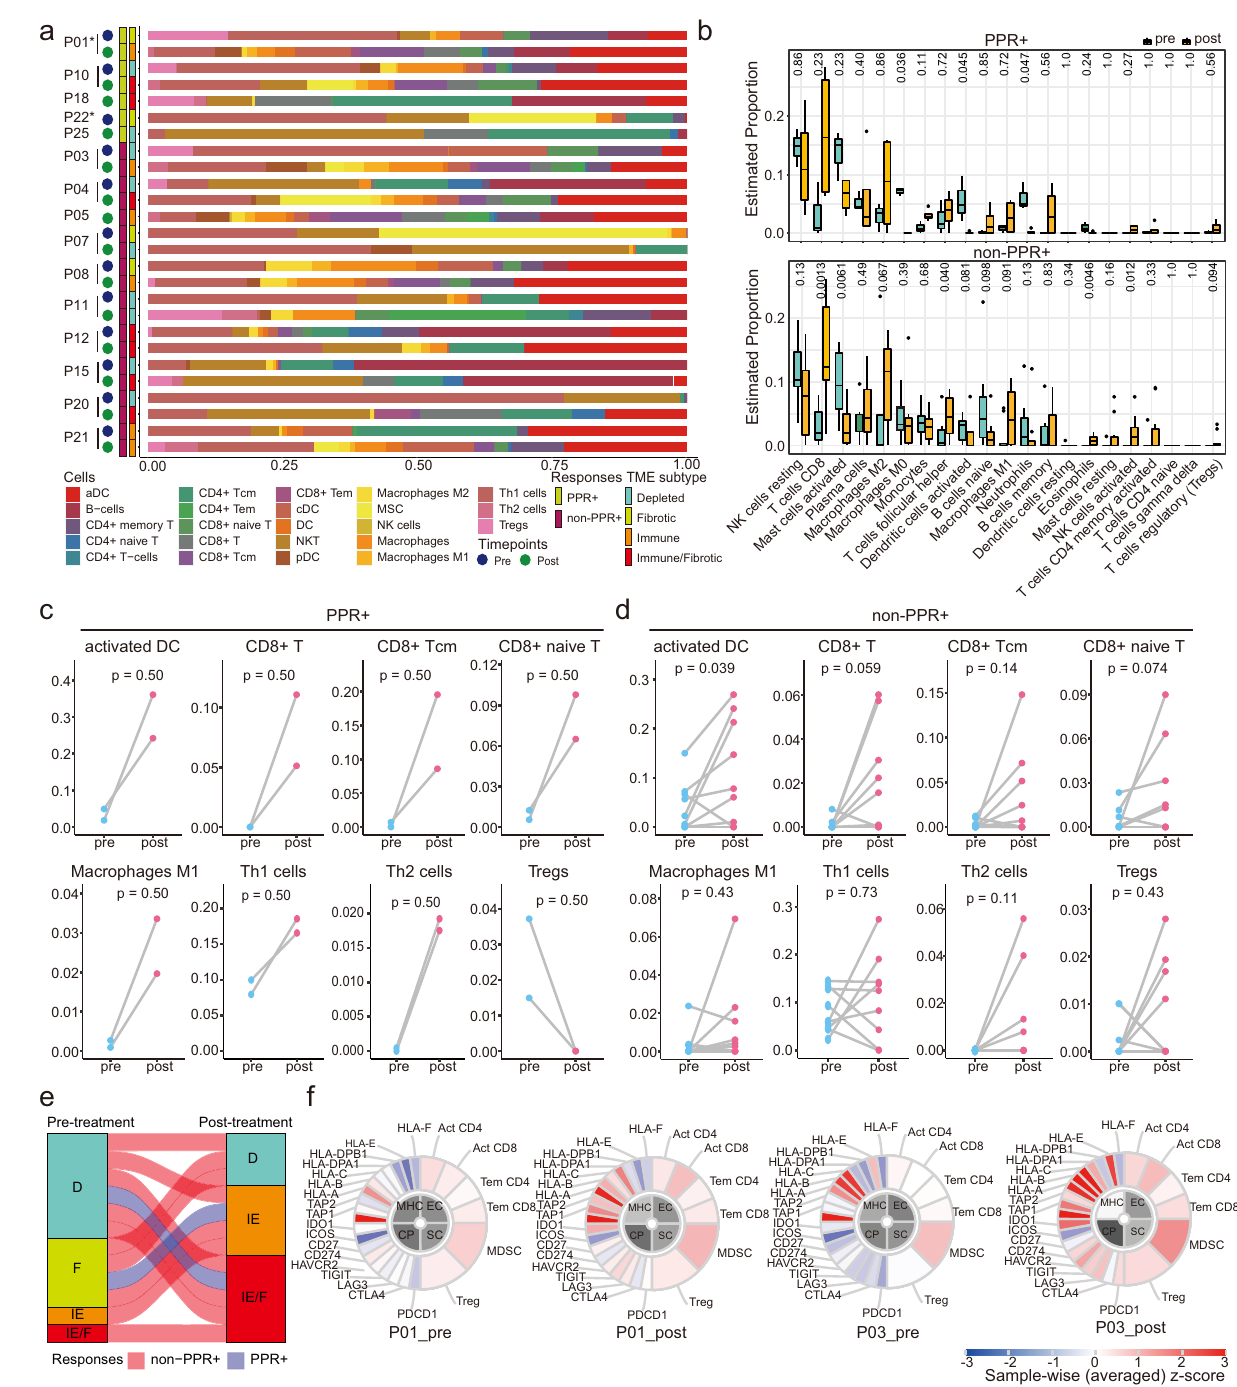
Sample-wise (averaged) z-score and non-PPR+ groups ( d , n =9).Two-sided Wilcoxon signed-rank test wasused for comparisonin c-d . e ChangesinTMEsubtypespre-topost-treatment.Tumorswere classi fi ed into four subtypes,including fi brotic(F), depleted (D),immune-enriched (IE),andimmune-enriched/ fi brotic(IE/F)types. f ImmunophenotypesofpatientsP1 and P3. The major determinants are involved in four categories: MHC molecules (MHC), immunomodulators (CP), effector cells (EC), and suppressor cells (SC). Source data are provided as a Source Data fi